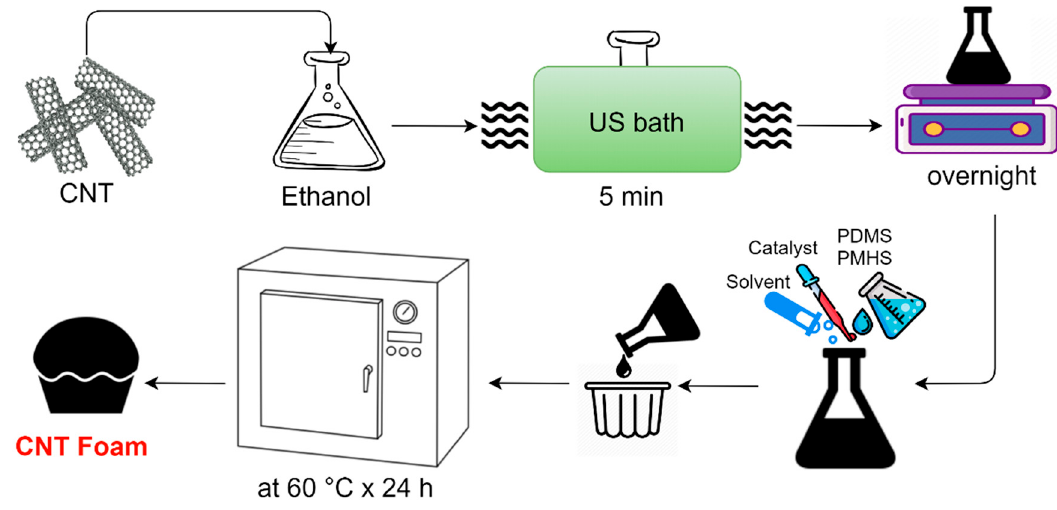
Figure 2. Foam synthesis procedure.